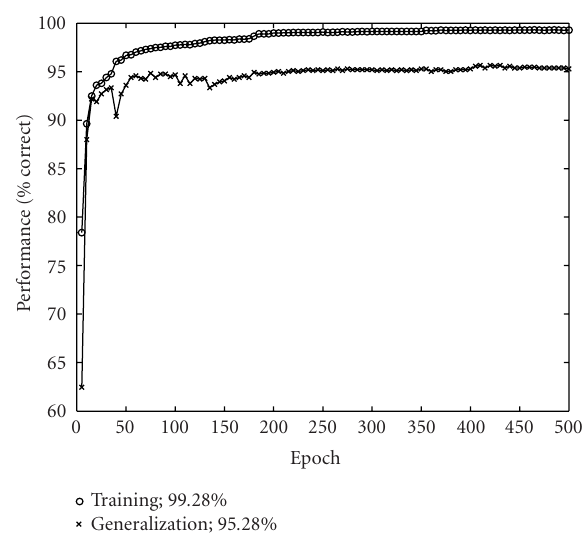
Figure 10: Performance curves during training and testing of the NN classifier with the RSF short